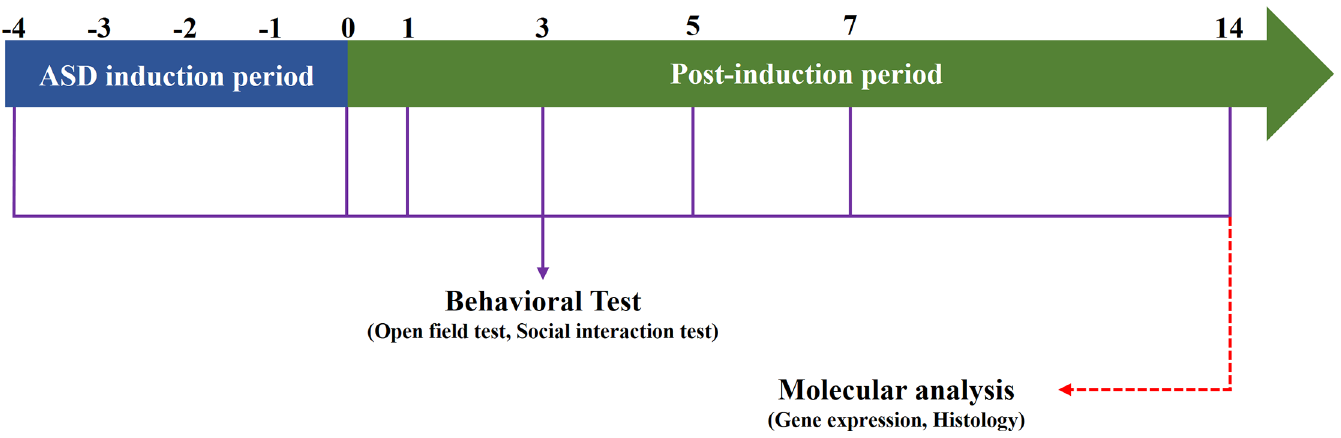
Fig 1. Schematic representation of experimental